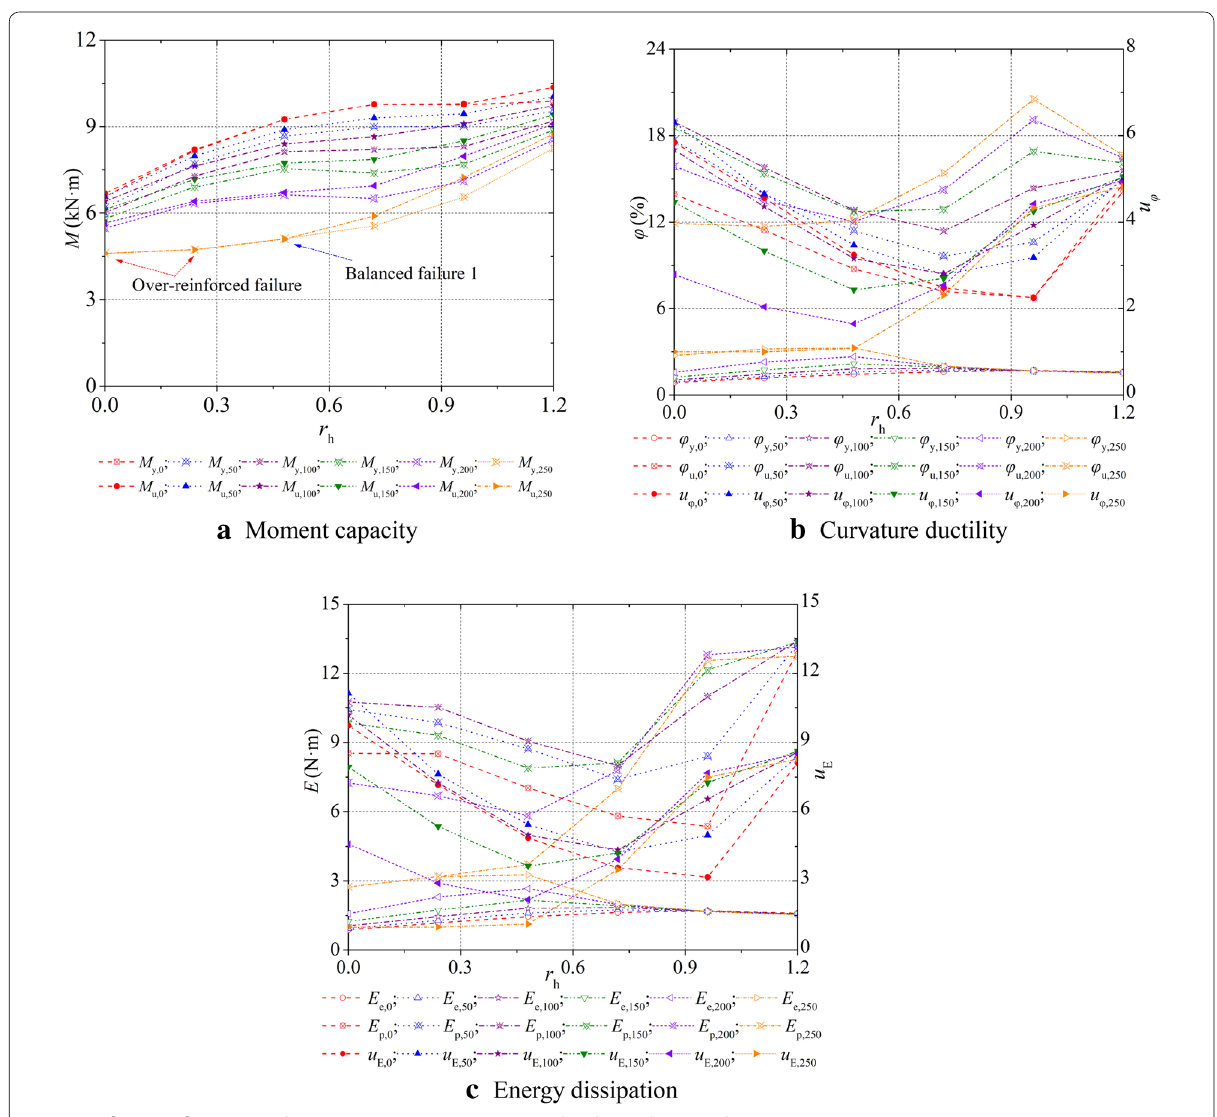
Fig. 15 Influence of ECC strength on moment capacity, curvature ductility and energy